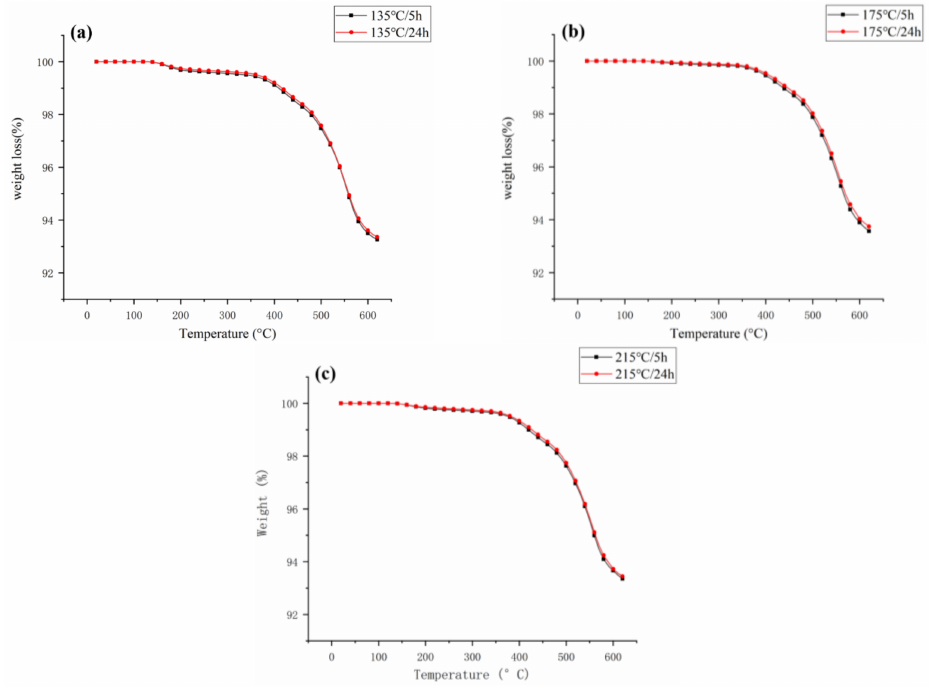
Figure 8. TGA curve of the coil bobbin after baking ( a ) 135 ◦ C, ( b ) 175 ◦ C, and ( c ) 215 ◦ C.